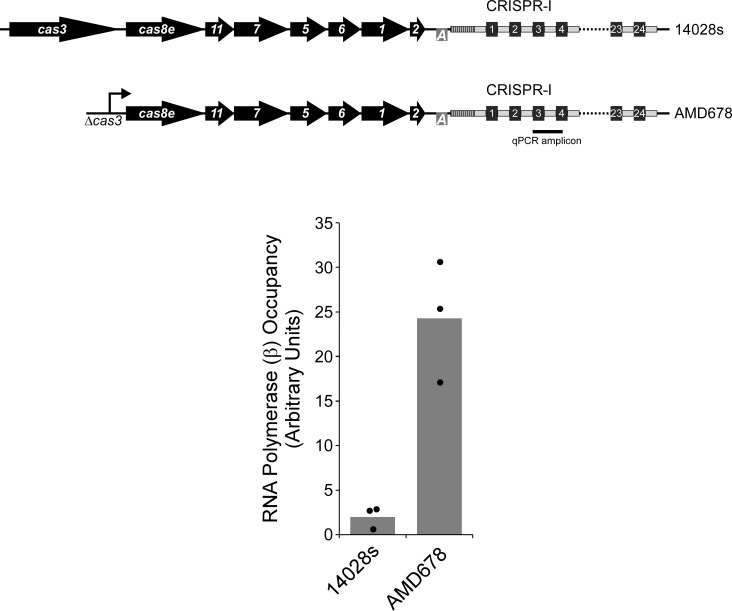
The CRISPR-I array is co-transcribed with the upstream cas gene operon.Occupancy of RNA polymerase (β subunit) measured by ChIP-qPCR within the CRISPR-I array in wild-type 14028s or AMD678, which has a constitutive promoter in place of cas3, as indicated in the schematic. The location of the qPCR amplicon is indicated on the schematic. Values shown with bars are the average of three independent biological replicates, with dots showing each individual datapoint.